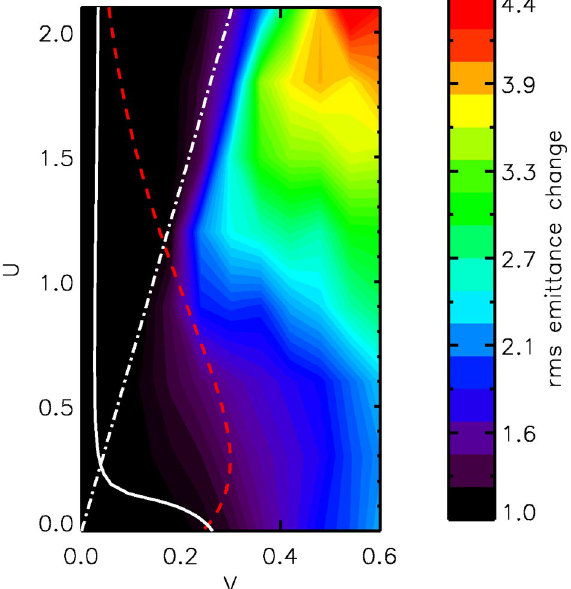
FIG. 8. (Color) Emittance increase in a sausage beam as a function of initial (cid:1) U; V (cid:5) values with n corresponds to a stable beam. .